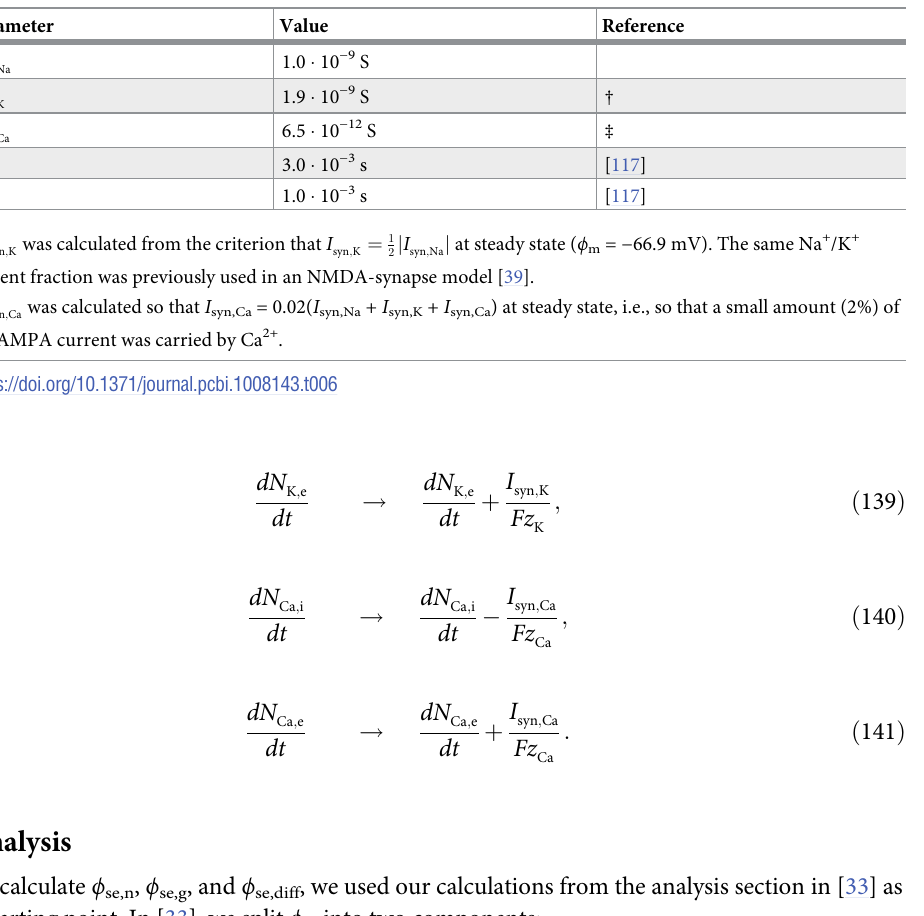
Table 6. Synaptic